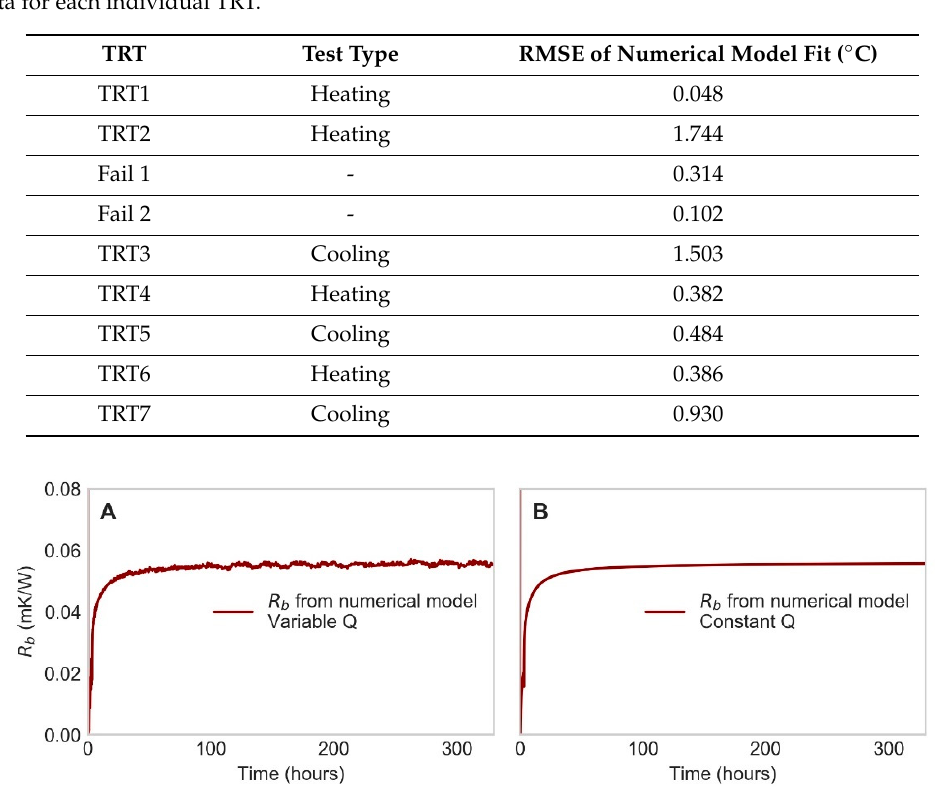
Table 4. Root Mean Squared Error (RMSE) of numerical forward simulation compared to measured data for each individual TRT.